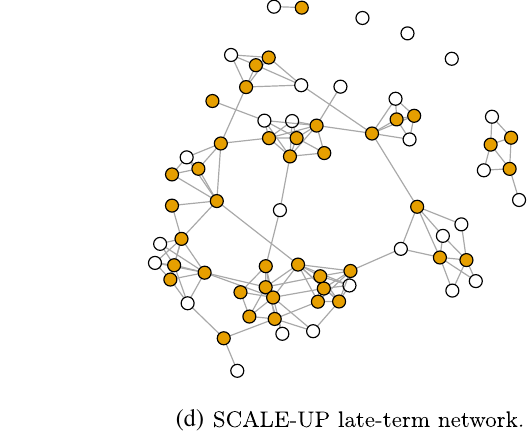
FIG. 2. Early- and late-term networks for Modeling Instruction (top row) and SCALE-UP (bottom row). The two classes had similar sizes, but different network